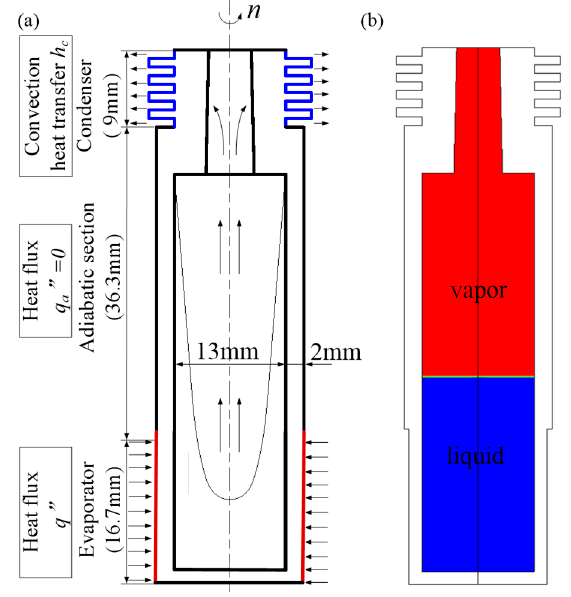
Figure 2. Simulation model ( a ) and boundary conditions ( b ).